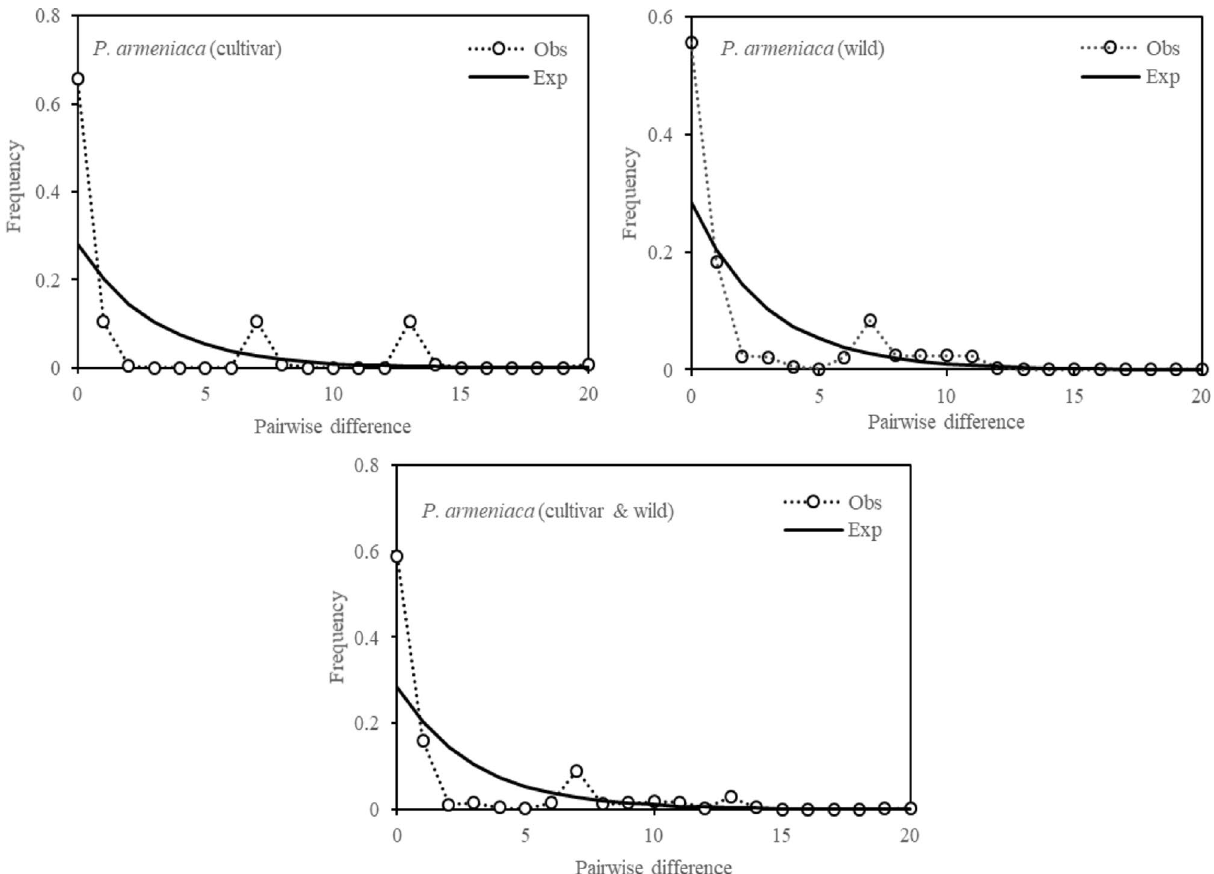
Figure 4. Mismatch distribution analysis of P. armeniaca based on overall gene pool of cpDNA dataset.